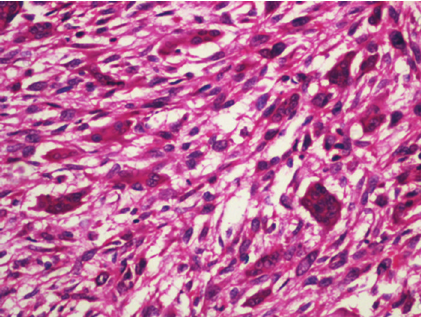
Figure 4: Spindle-shaped tumor cells showing cytoplasmic positiv- ity for cytokeratin (IHC for cytokeratin,